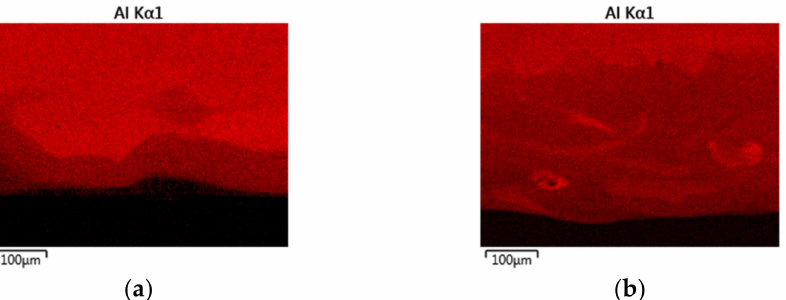
Figure 17. EDX mapping of the Al distribution within the transition zone showing the differences in intermixing between the processing of pre-alloyed ( a ) and elemental ( b )